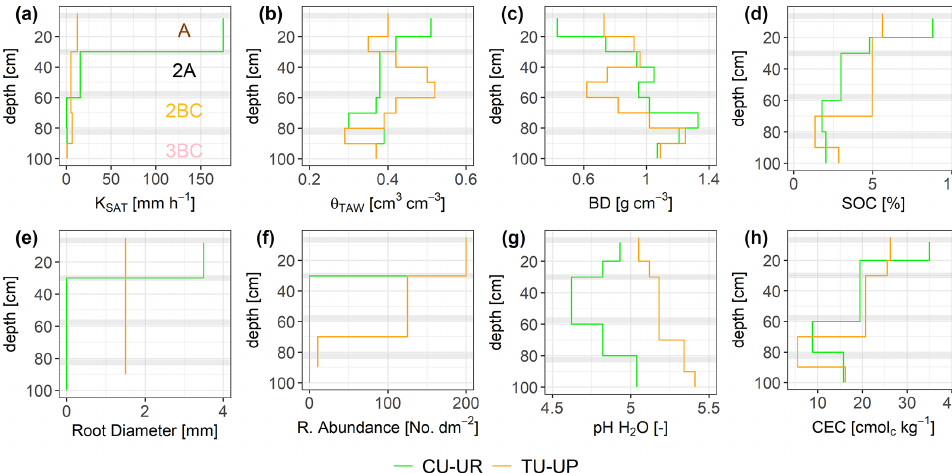
Figure 3. Depth-specific distribution of soil properties: (a) saturated hydraulic conductivity ( K SAT ), (b) total available water ( θ TAW ), (c) dry bulk density (BD), (d) soil organic carbon (SOC), (e) root diameter, (f) root abundance, (g) soil pH, and (h) cation exchange capacity (CEC). Horizontal gray bars indicate the boundaries between soil horizons. The information of the soil pits under cushion-forming plants (CU-UR) is plotted in green color, while the information from soils under tussock grasses (TU-UP) is plotted in